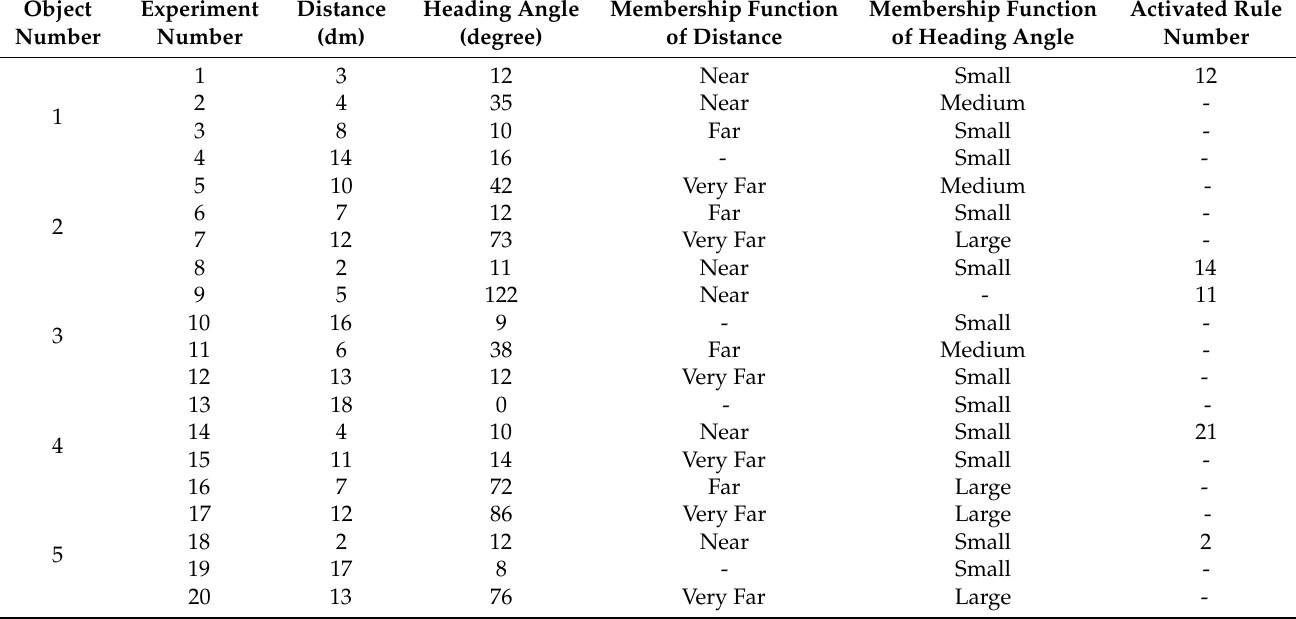
Table 2. Result of the experimental test. There were 20 experiments with various variations on the user’s localization data and IoT devices’ status. There were five different objects, and the user’s distance from them was measured simultaneously. The localization data can be varied through the user’s movement and heading angle. We also checked the activated fuzzy rule and its reliability in each